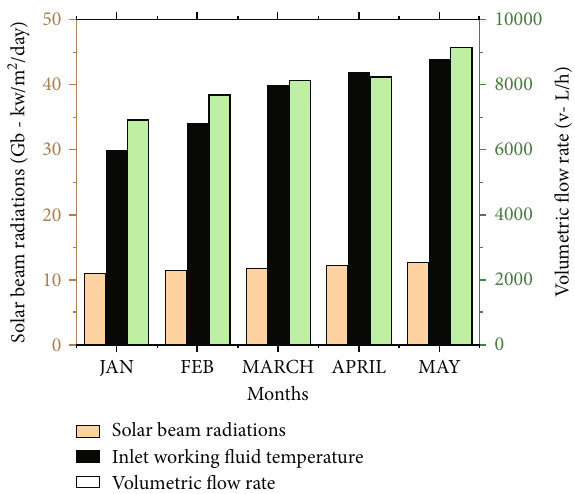
Figure 15: Measured data for solar beam radiations, inlet working fl uid temperature, and volumetric fl ow rate from January 2020